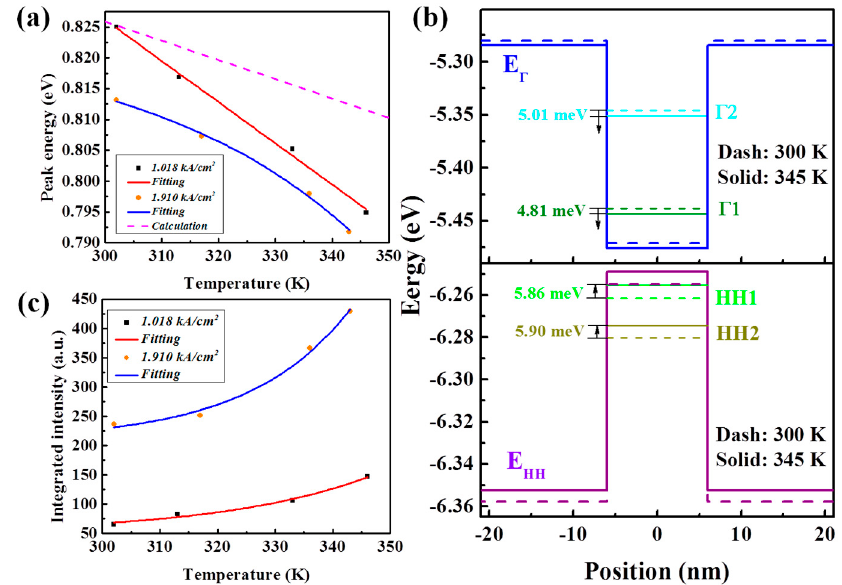
Figure 7. ( a ) Energy variation of EL peaks under constant injection current densities of 1.018 kA/cm 2 and 1.910 kA/cm 2 versus the environmental temperature. The energy of the Γ 1-HH1 transition from the calculated results is also plotted; ( b ) Band alignment for the MQWs at 345 K from calculated results based on [36]; ( c ) Variation of integrated EL intensity under the constant injection current densities of 1.018 kA/cm 2 and 1.910 kA/cm 2 versus the environmental temperature.